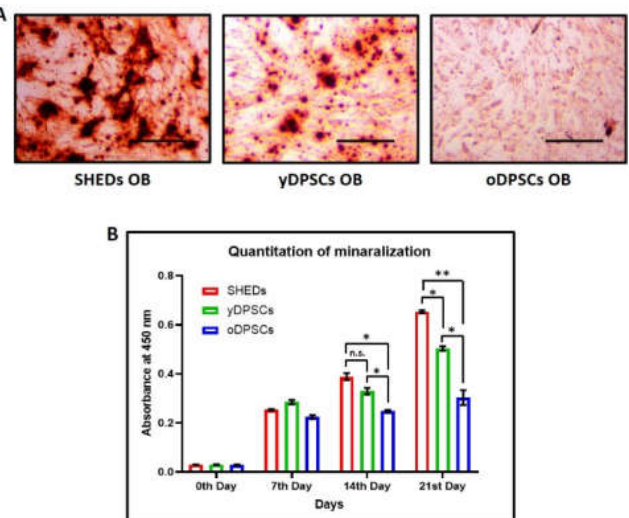
Figure 2. Osteogenic differentiation of SHEDs, yDPSCs, and oDPSCs. ( A ) Differentiated osteoblasts from SHEDs, yDPSCs, and oDPSCs stained for mineralization with alizarin red s. ( B ) Quantitation of alizarin red s for comparative estimation of mineralization in osteoblasts differentiated from SHEDs, yDPSCs, and oDPSCs ( n = 5). n.s.: not significant, * p < 0.05, ** p < 0.01. SHEDs: Stem cells from exfoliated deciduous tooth, yDPSCs: Dental pulp stem cells from young subjects, oDPSCs: Dental pulp stem cells from old subjects, OB: osteoblasts.